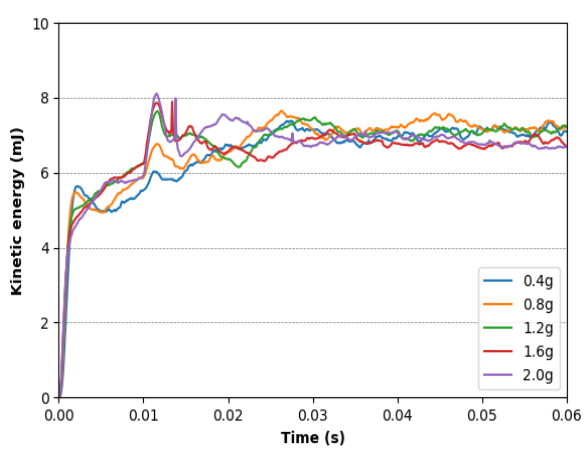
Fig 2: Kinetic energy for each particle system Overall, the highest particle velocity was recorded in the 0.4 g loading case. Compared to the other cases, fewer particles are accelerated and collisions occur less frequently. This allows the particles to achieve a higher velocities for lower loadings. Figure 3 displays a radial velocity profile of a single slice taken through the bed.